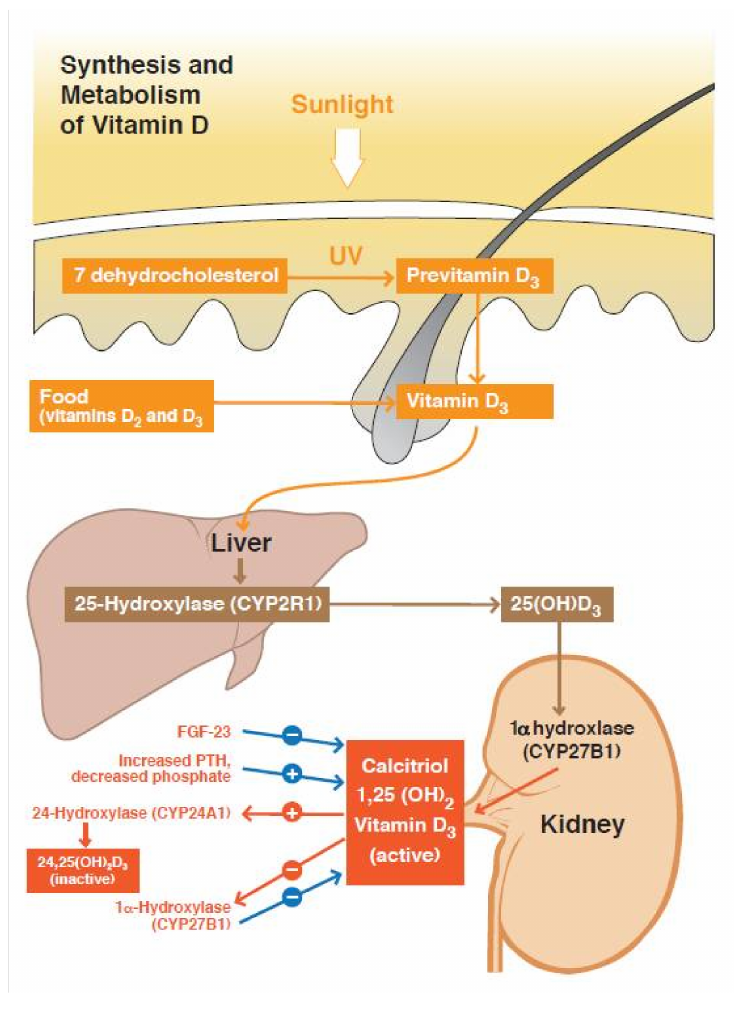
Figure 1. Summary of the vitamin D pathway. Vitamin D activation involves the action of 25- hydroxylase (liver) and 1 α -hydroxylase (kidney). Calcitriol or vitamin D1,25(OH) 2 can bind its receptor to exert its biological action. Vitamin D inactivation involves 24-hydroxylase. This en- zyme can metabolize vitamin D25(OH) to the intermediate metabolite vitamin D24,25(OH) 2 and vitamin D1,25(OH) 2 to vitamin D1,24,25(OH) 3 . The activity of 1 α -hydroxylase and 24-hydroxylase is regulated mainly by PTH and FGF23. FGF23 = fibroblast growth factor